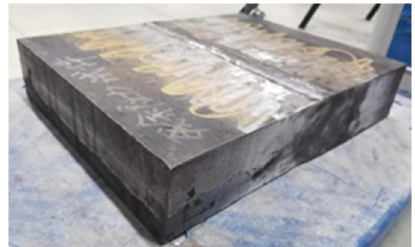
Figure 1. The butt ‐ welded thick steel plate.